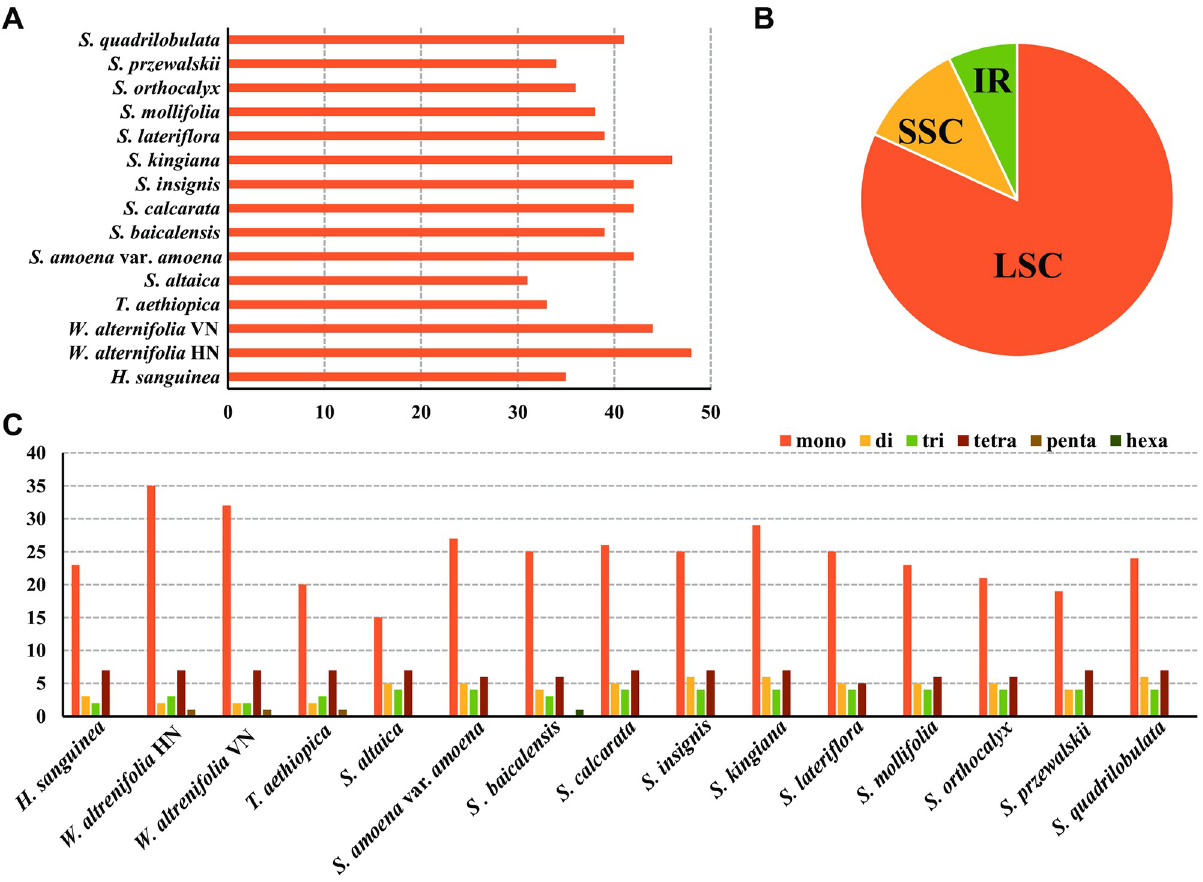
Fig 2. Comparisons of the simple sequence repeats (SSR) among the 15 plastomes of Scutellarioideae. (A) Number of SSRs detected in each plastome; (B) Frequencies of identified SSRs in LSC, IR, and SSC regions; (C) Number of SSR types detected in each plastome.